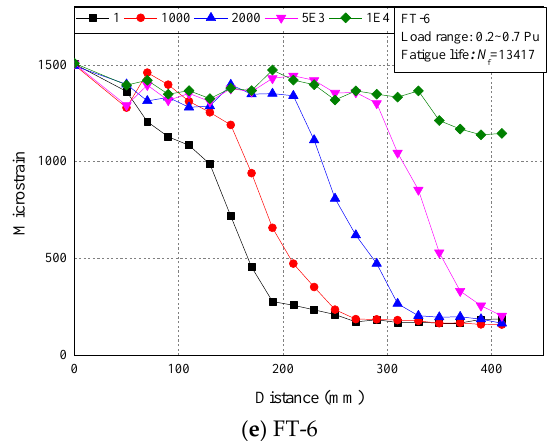
ff erent fatigue load